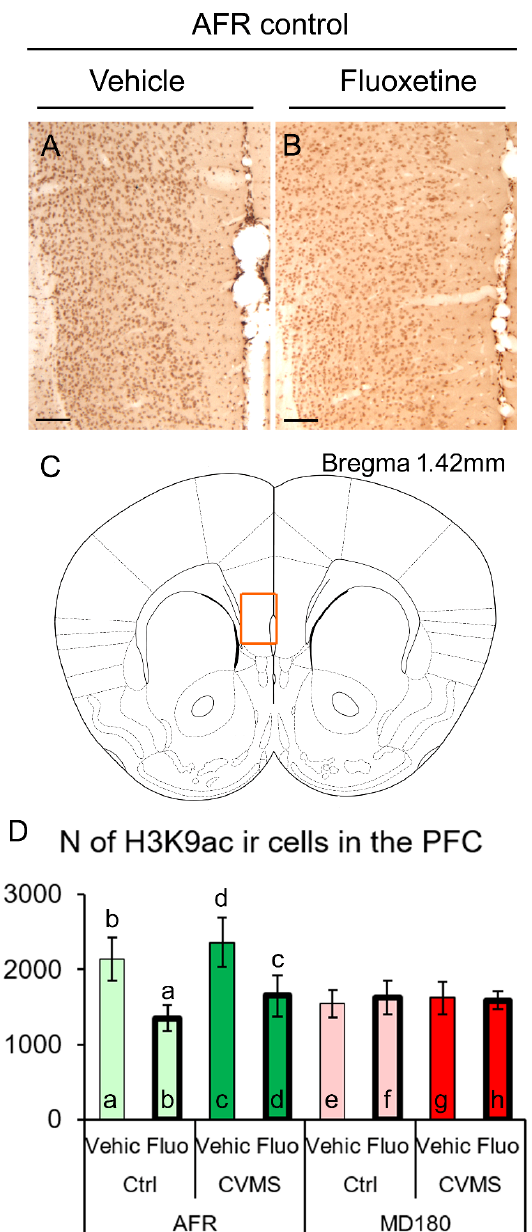
Figure 1. Acetyl ‐ lysine 9 H3 histone (H3K9ac) immunoreactivity (ir) in the prefrontal cortex (PFC). Representative images illustrating H3K9ac ‐ ir nuclei in the PFC of vehicle (Vehic) ( A ) and fluoxetine (Fluo) ‐ treated PACAP heterozygous control (Ctrl) AFR mice. The imaged area shown in ( A , B ) corresponds to highlighted PFC region in ( C ) (scheme modified after Paxinos and Franklin [62]). Histogram ( D ) illustrates the dynamics of H3K9ac ‐ ir cell counts. Lettering indicates the most relevant significant differences between pairs of groups, according to the post hoc tests (n = 4–6). AFR: animal facility rearing, CVMS: chronic variable mild stress, MD180: 180 min maternal deprivation. Bars: 100 μ m.